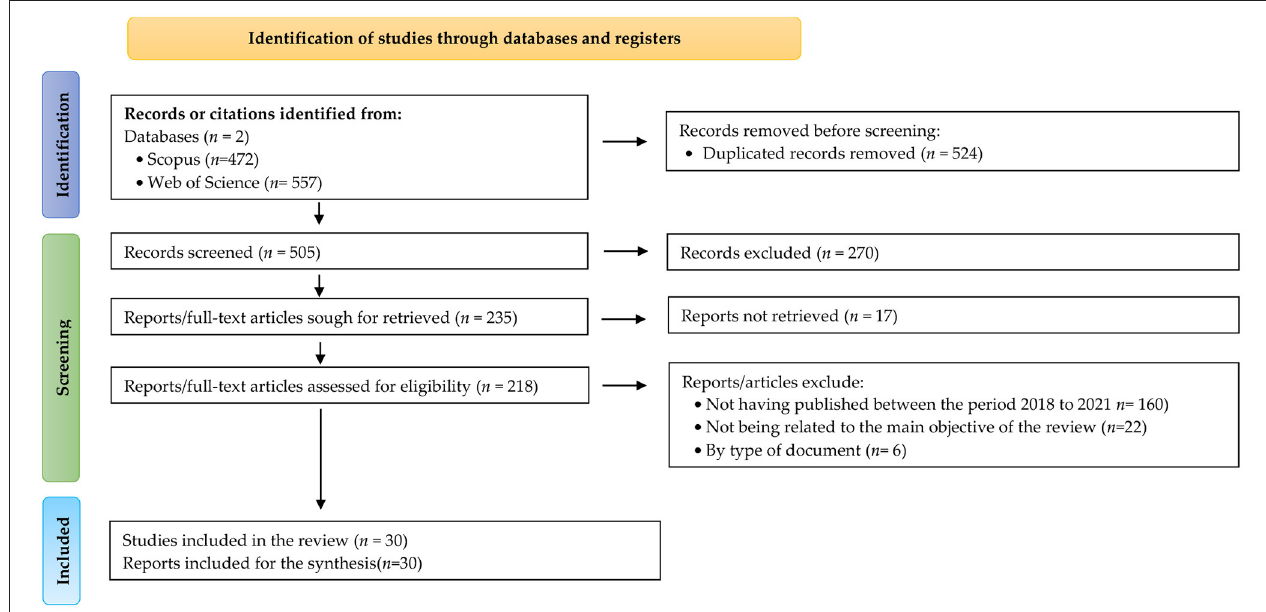
FIGURE 4 | PRISMA flow chart of the selection processes for the articles included in the study following the PRISMA 2020 design from Page et al. (2021).